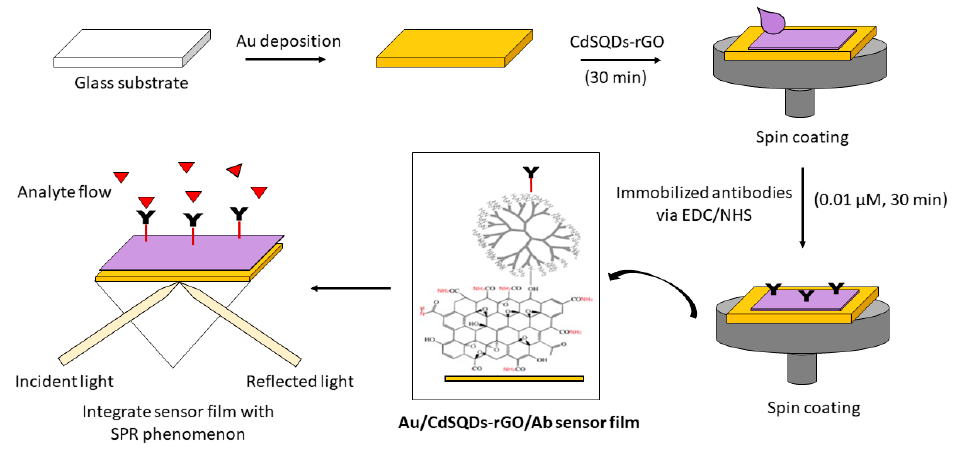
Figure 3. Schematic diagram of the experimental procedure.